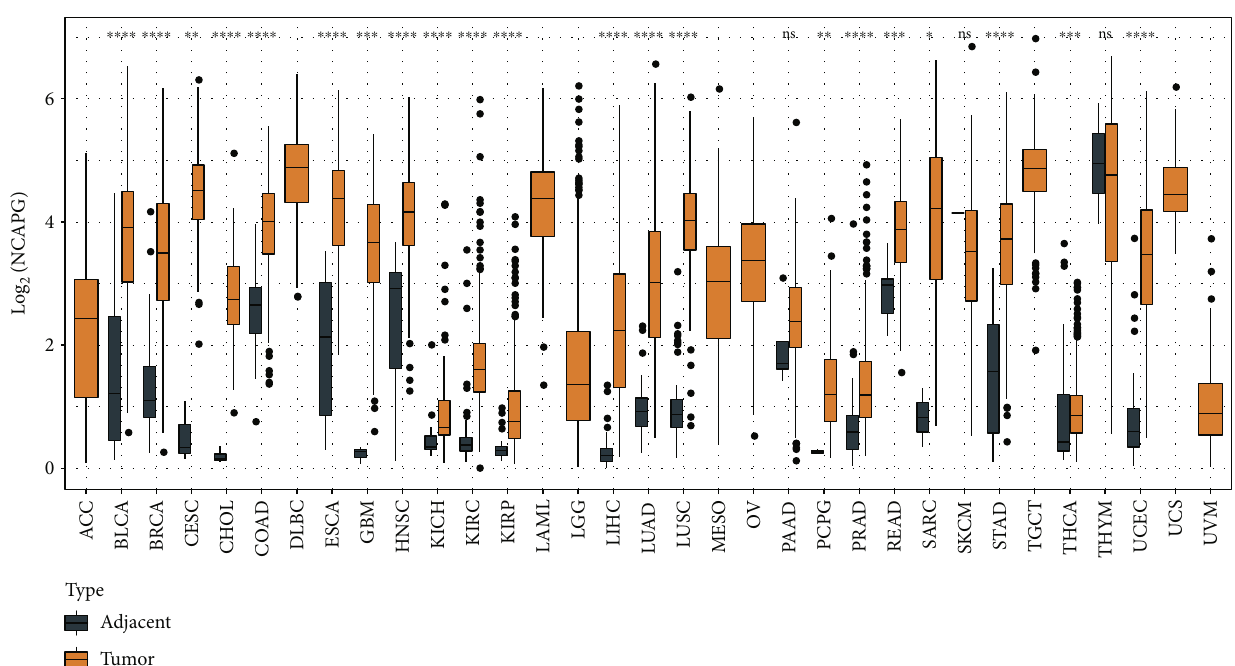
Figure 2: Pan-cancer di ff erential expression of gene NCAPG between cancer and para-cancer tissues. Yellow represents signi fi cantly high expression in tumors ( ∗ , P < 0 : 05 ; ∗∗ , P < 0 : 01 ; ∗∗∗ , P < 0 : 001 ; ∗∗∗∗ , P < 0 : 0001 ; ns, P > 0 : 05